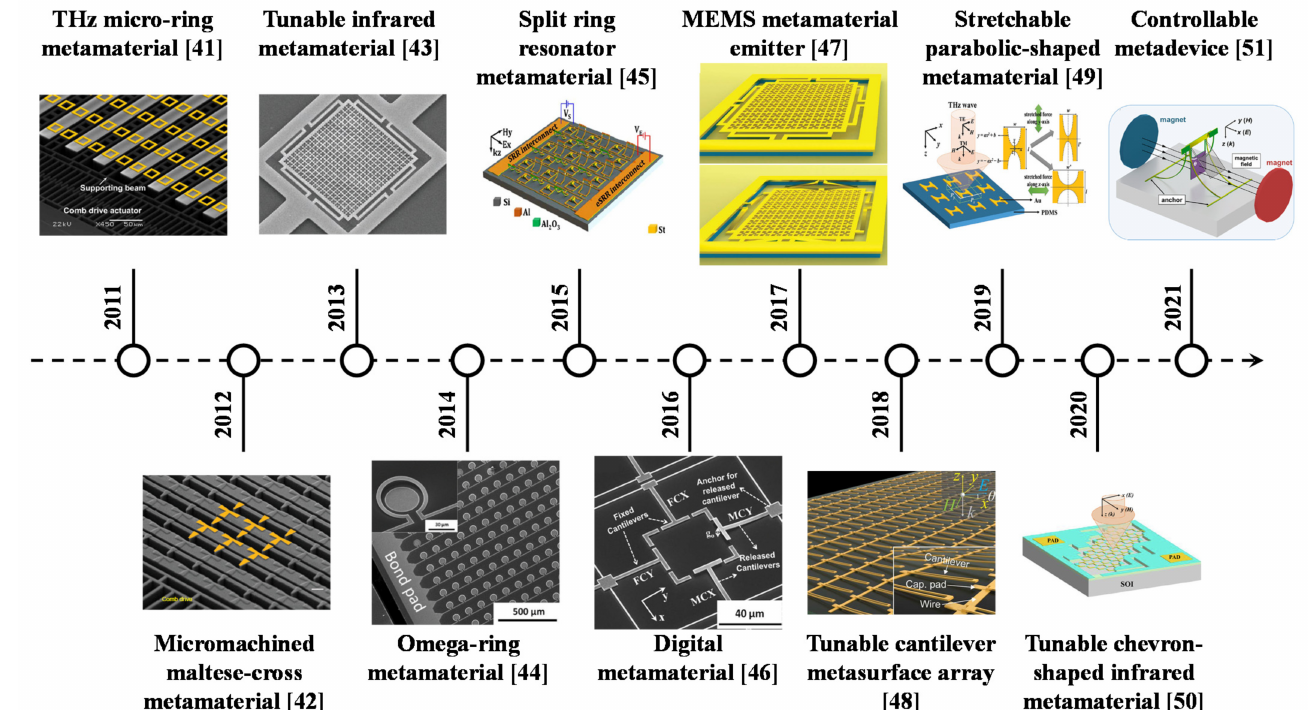
Figure 1. The development of MEMS-based tunable metamaterial in the last ten